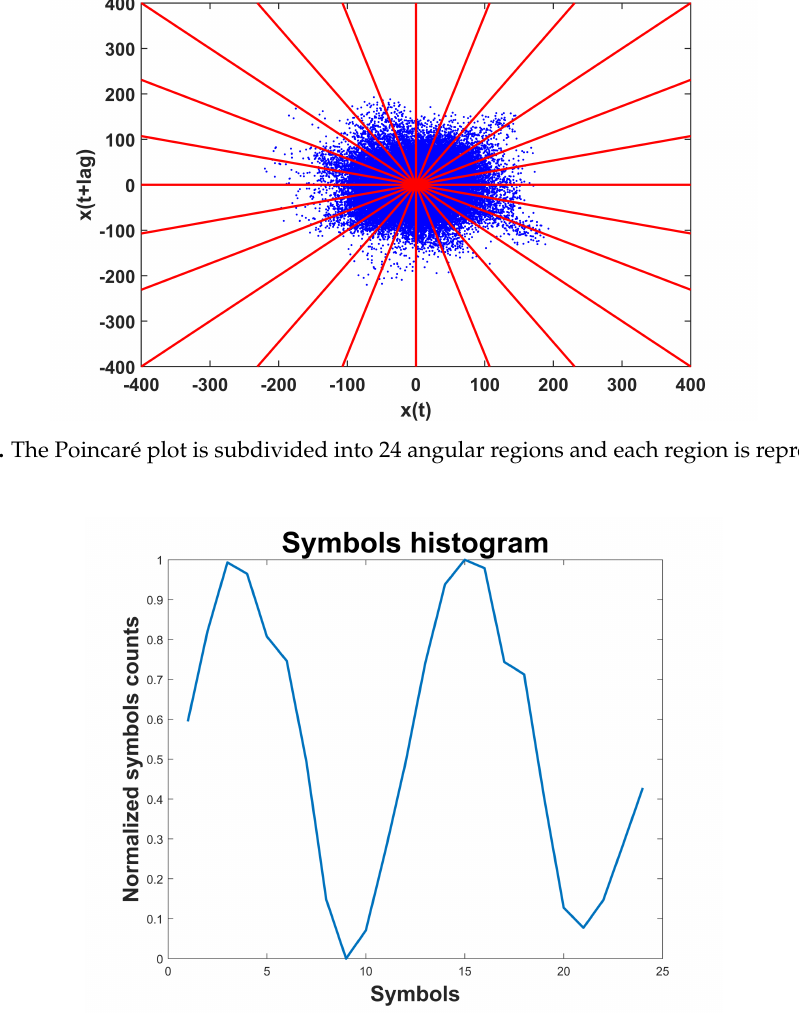
Figure 15. Histogram of symbols for the healthy case P1 of the reciprocating compressor.